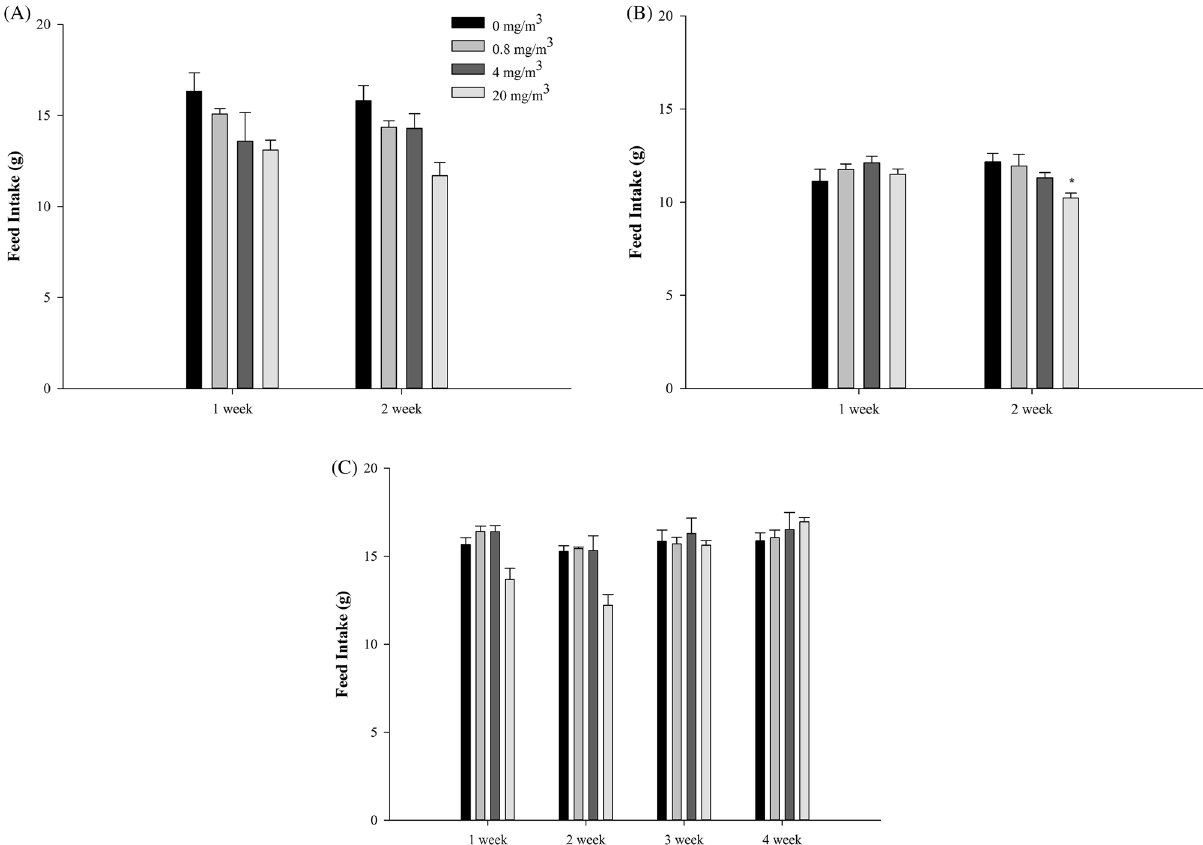
Figure 3. Changes of feed intake in the rats exposed to NaDCC. Males ( A ) and Females ( B ) in the main groups, Males ( C ) in the recovery groups. Significantly different from control by Dunnett LSD test: *p <